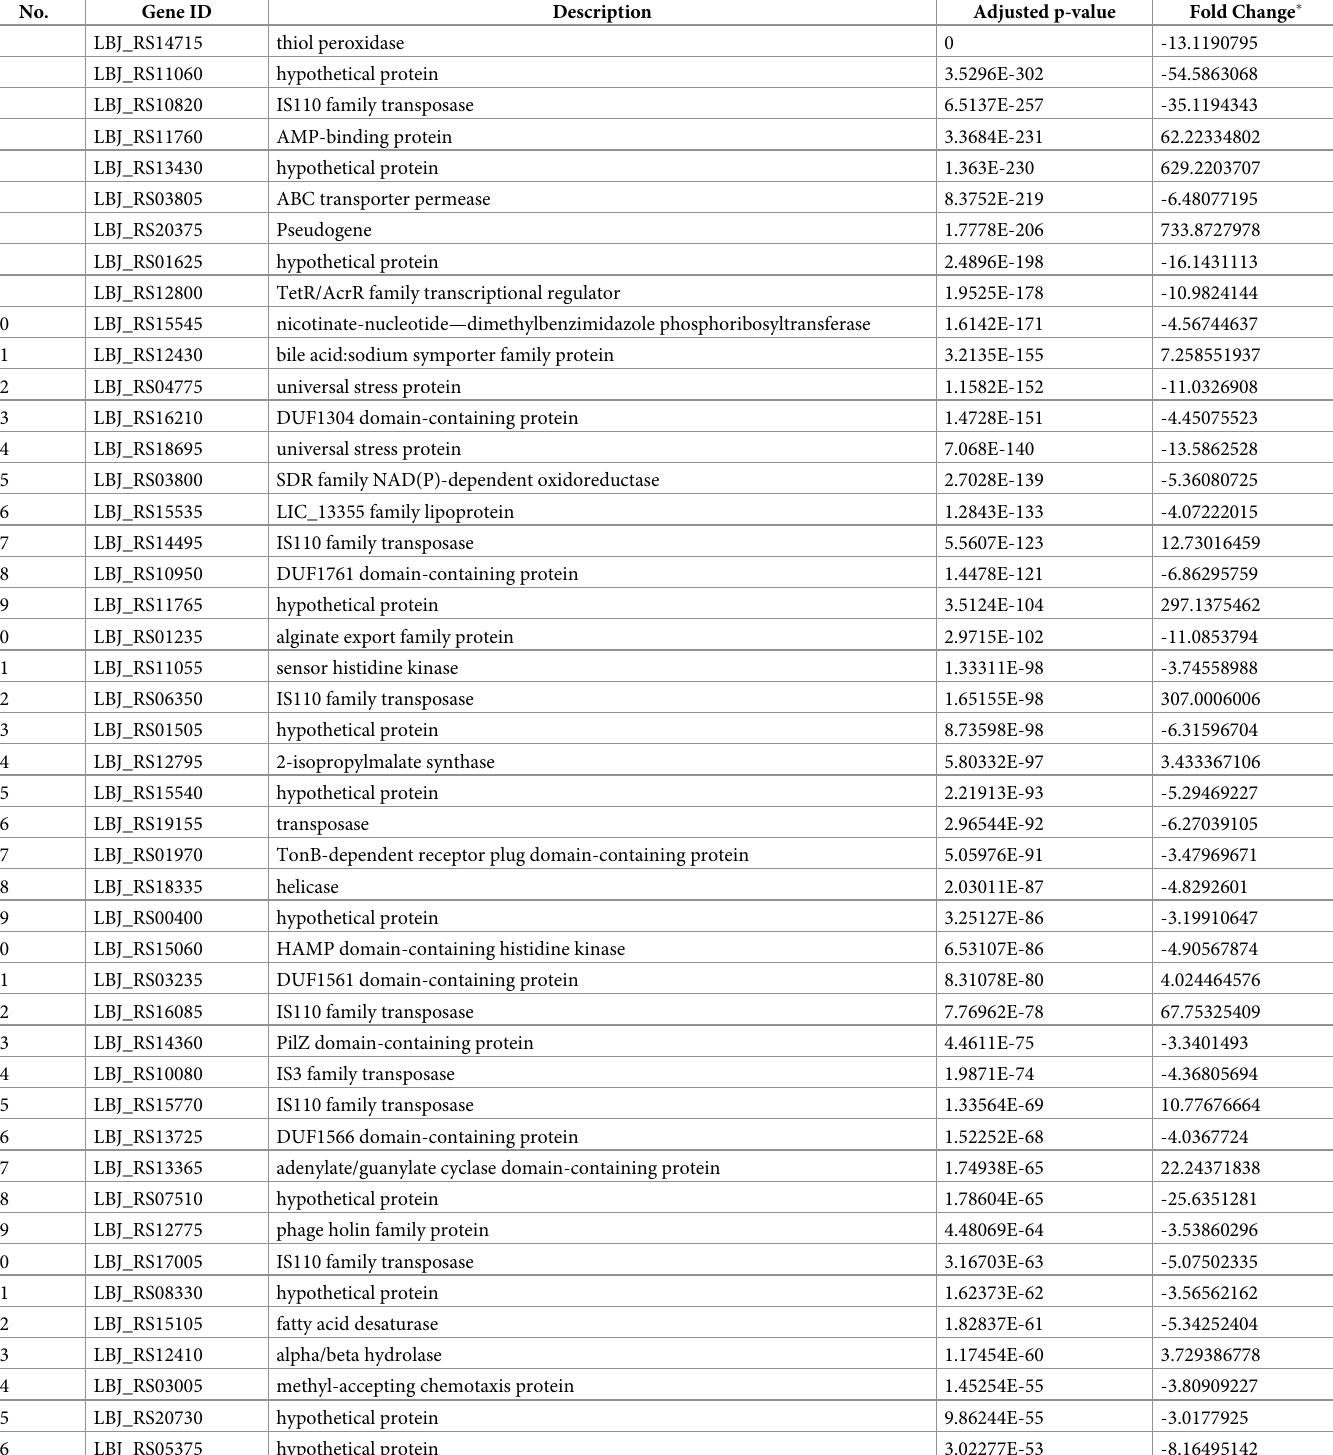
Table 3. The fifty most significantly differentially expressed genes between JB197 vs. HB203 grown at 37˚C. All genes are relative to the JB197 reference genome and annotated by the JB197 gene ID. � Positive fold change values denote higher transcription in JB197 and conversely, negative values indicate higher expression in HB203.